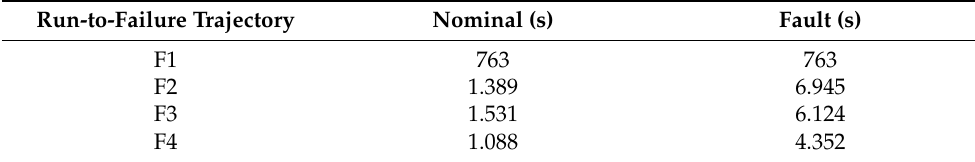
Table 12. Length of nominal and fault signals considered for the correlation coefficient computation.